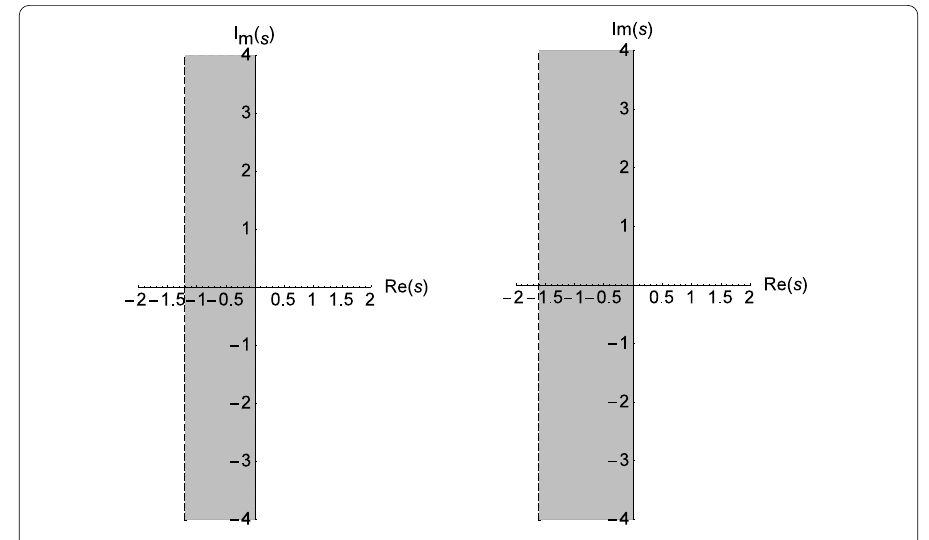
Figure 2 The complex strip (1 + α ,0) for α = –2.2 (on the left) and α = –2.6 (on the right)